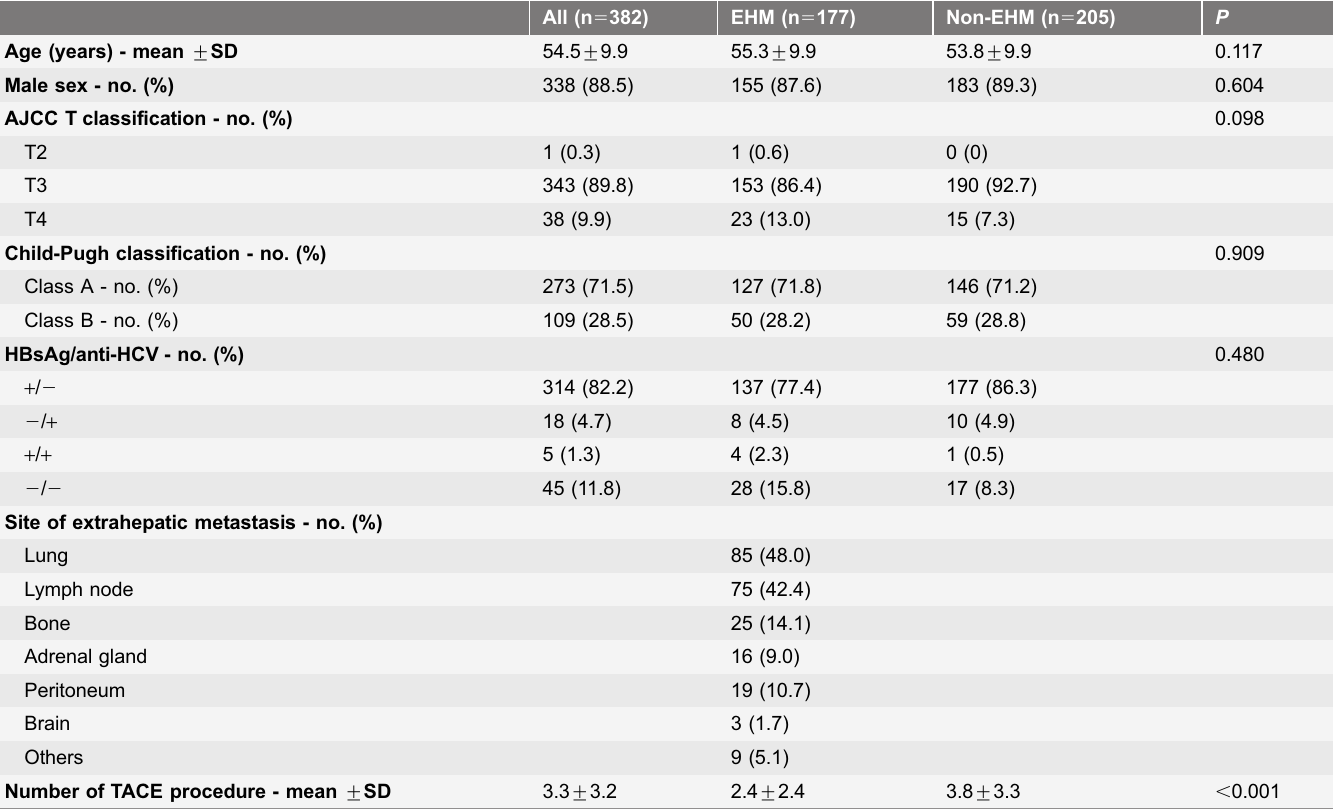
Table 1. Baseline characteristics of patients who have advanced HCC with and without extrahepatic